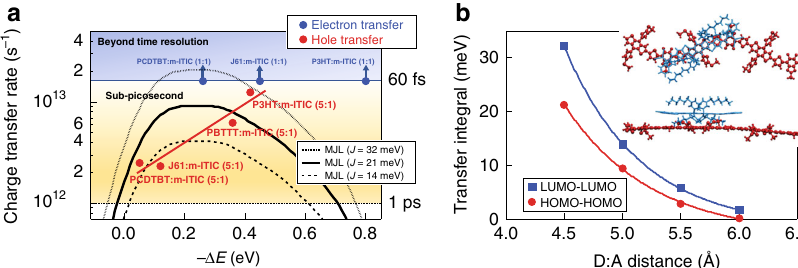
Fig. 4 Relationship between the driving force and the HT and ET rates. a The charge-transfer rate (inverse of the fi rst time constant obtained from the analysis of the TA dynamics) for ET and HT in different polymer:m-ITIC BHJ blends is plotted against the driving force (obtained from the sEQE and EL spectra). The red solid line is a guide for the eye to show the trend in HT rate, while the black curves represents the CT rate predicted from semiclassical Marcus – Levich – Jortner theory (with transfer integral J DA = 14 – 32 meV, Huang − Rhys parameter S = 1 and outer re-organization energy λ ο = 0.15 eV). b LUMO – LUMO transfer integral for ET and HOMO – HOMO transfer integral for HT in a J61:m-ITIC complex as a function of the donor:acceptor (D:A) distance. The geometry as obtained by DFT calculations (at 4.5 Å) is depicted in the